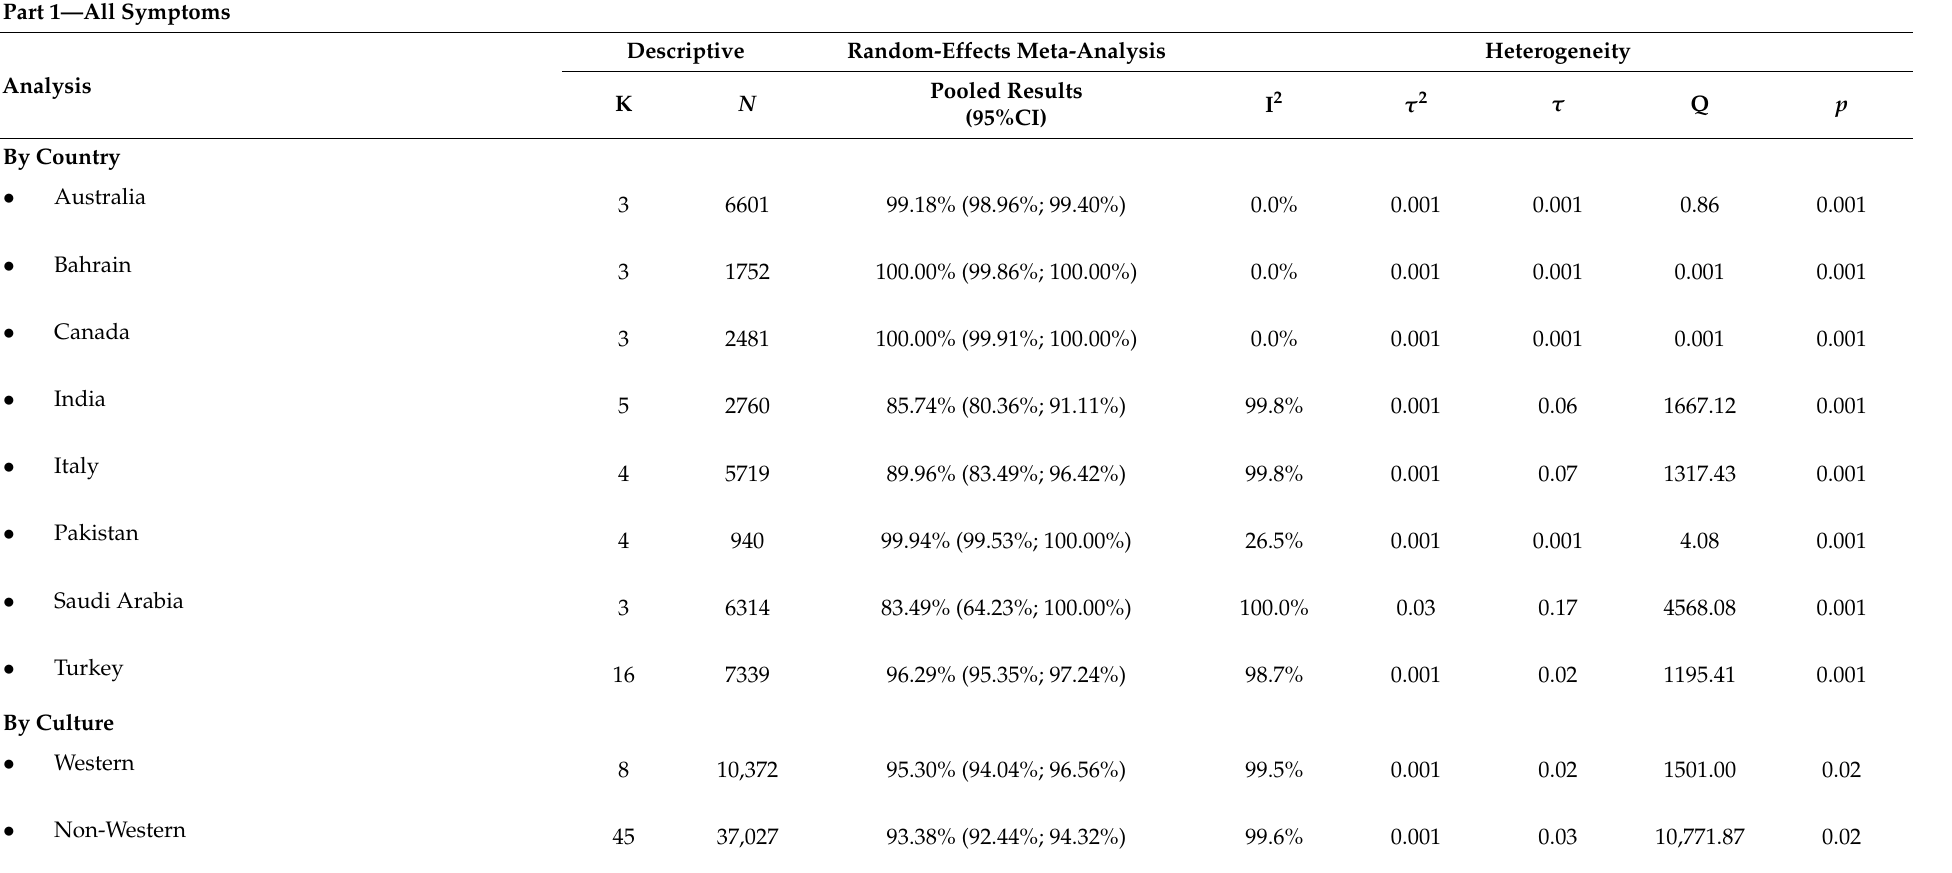
Table 3. Results of the random-effects subgroup meta-analysis models of the prevalence of nomophobia symptoms by country, culture, population, tool, and